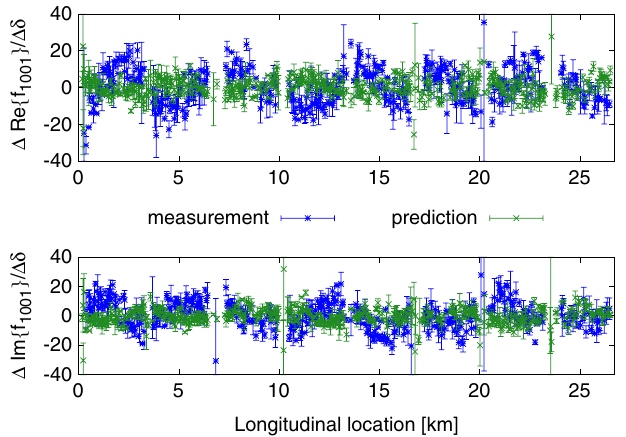
FIG. 8. Comparison between the measured chromatic coupling after correction (red) and the predicted chromatic coupling after correction from our model (green). This is for beam 1 at (cid:1) (cid:10) ¼ 0 : 6 m